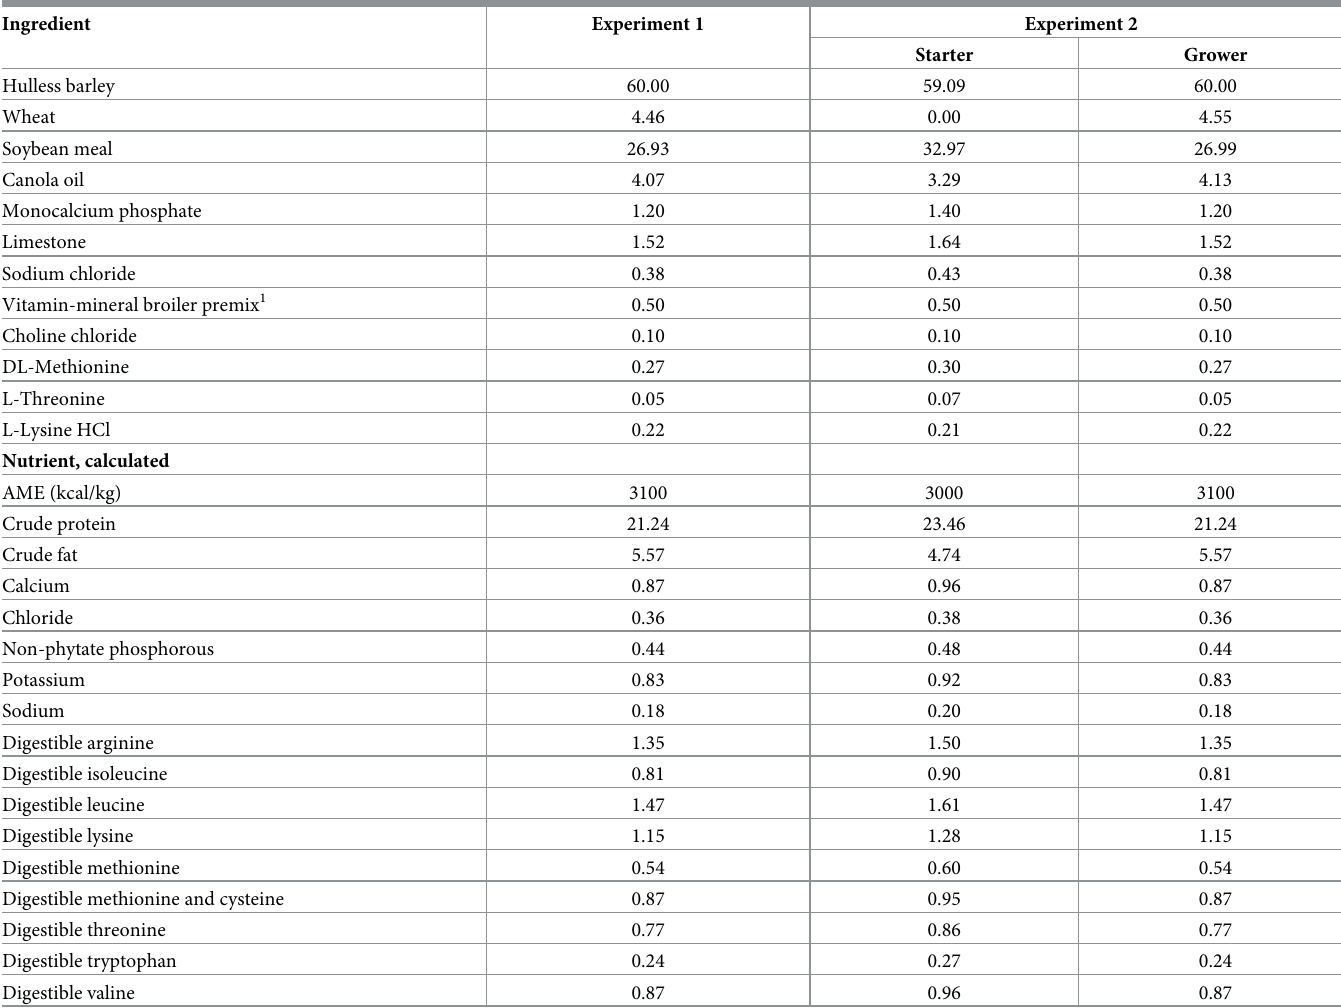
Table 1. Ingredients and calculated nutrient levels (%) of experimental